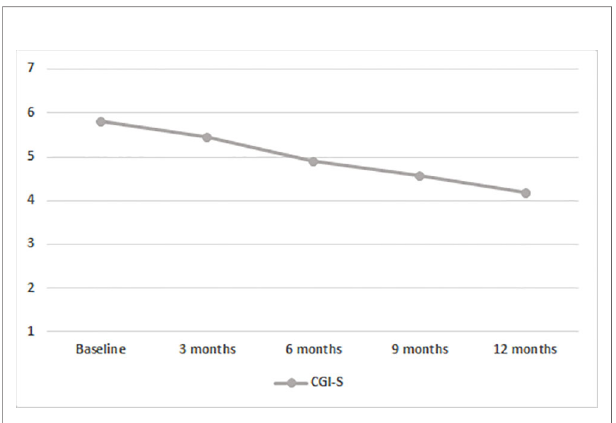
FIGURE 2 | Time course of CGI-S scores in the entire population. BL, baseline; CGI-S, Clinical Global Impressions Scale-Severity of